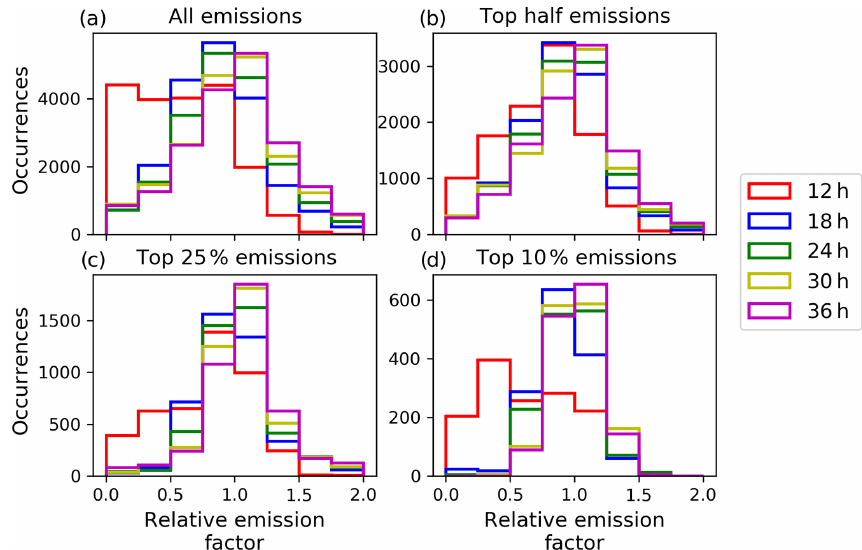
Figure 11. Histogram of the relative emission factors for different assimilation window lengths for the test case on 15 April, 2010 with color codes as in Fig. 3. The relative emission factor is calculated according to Eq. (14). The histograms are shown for (a) all emission rates, (b) the top half, (c) the top 25%, and (d) the top 10% emission rate.